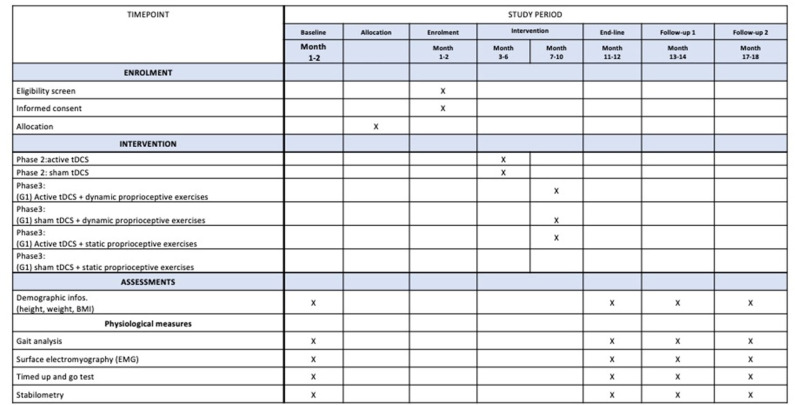
Schedule of enrollment, assessments, and interventions for participants.